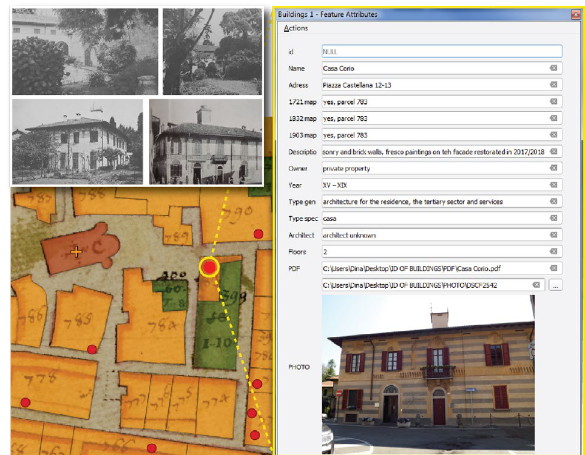
Figure 5. Point feature: A “container” with information